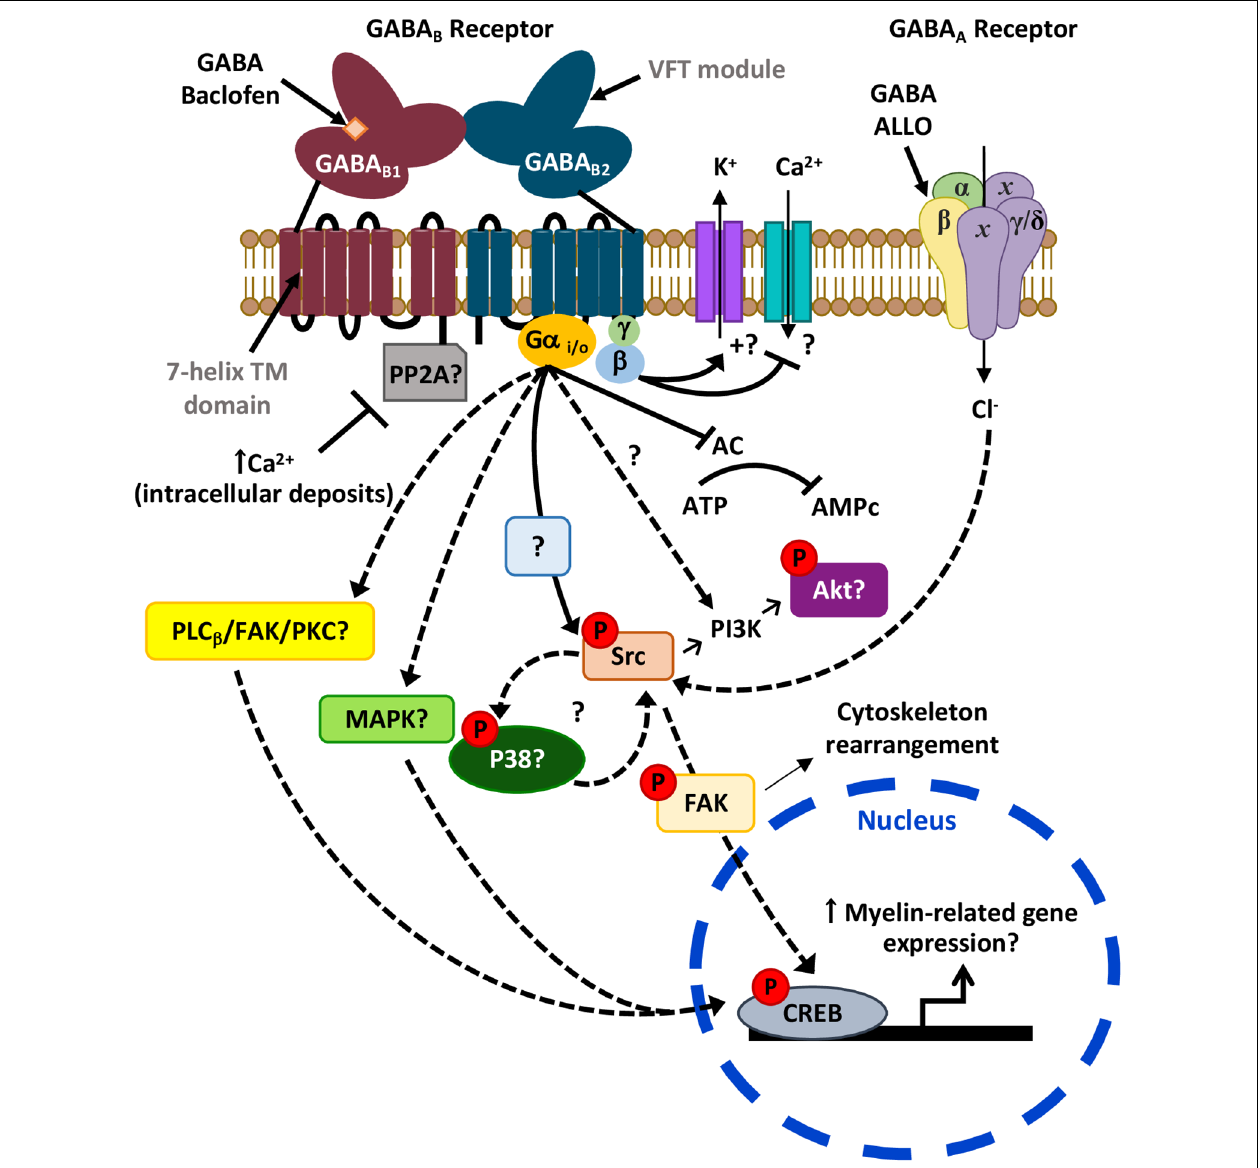
FIGURE 3 | Possible signaling pathways downstream GABARs leading to myelination. Activation of the Gi/o-linked GABA B R may reduce CREB phosphorylation as it is negatively coupled to adenylyl cyclase (AC; Luyt et al., 2007). Alternatively, it may also induce CREB phosphorylation possibly via activation of PLC β /FAK/PKC or MAPK cascades, as observed in neurons (Carlezon et al., 2005; Zhang et al., 2015). Moreover, activation of GABA B R leads to Src phosphorylation (Serrano-Regal et al., 2020) that could ultimately induce CREB activation. Phosphorylation of Src may also lead to Akt phosphorylation via PI3K as observed earlier (Barati et al., 2015), and contribute to a positive feedback loop with p38MAPK (Mugabe et al., 2010; Lin et al., 2015), which is involved in myelination (Fragoso et al., 2003, 2007). On the other hand, the GABA B1 subunit of GABA B R might be sequestered by phosphatases like PP2A (as occurs in some neurons), a mechanism that blocks its activity and can be reverted by high intracellular Ca 2+ levels (Li et al., 2020). Finally, the GABA A R allosteric modulator ALLO regulates Schwann cell (SC) myelination via Src-FAK signaling, involving cytoskeleton reorganization (Melfi et al.,